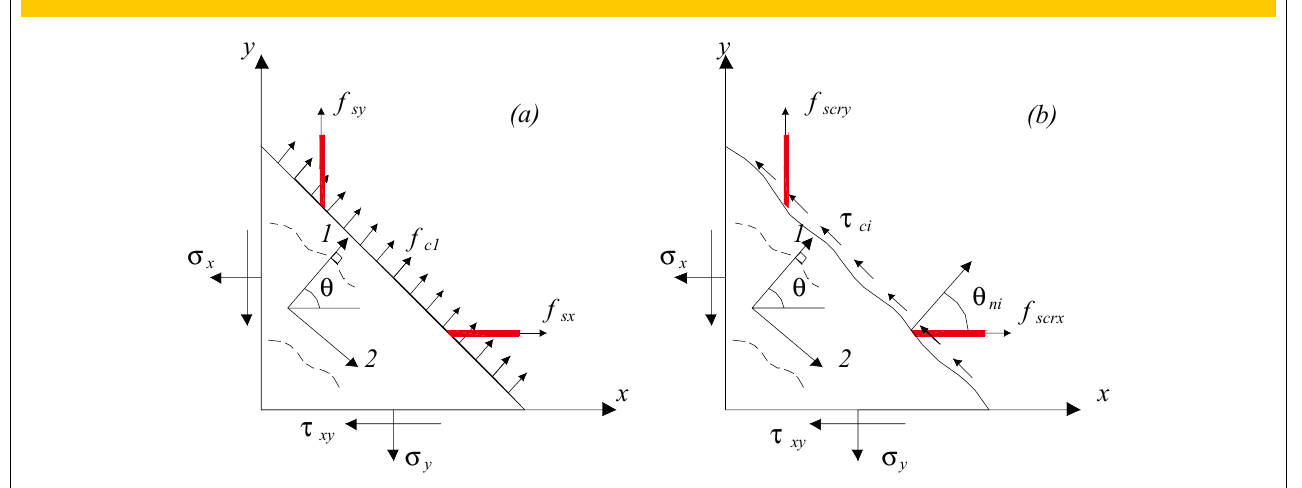
Figure 5 – (a) Average stresses between cracks and (b) local stresses at crack free